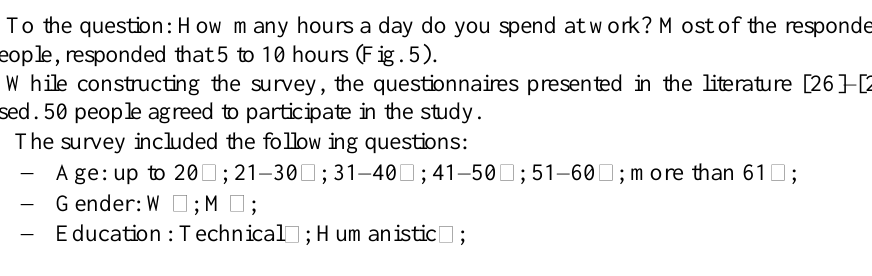
Fig. 5. The answer to the question: How many hours a day do you spend at